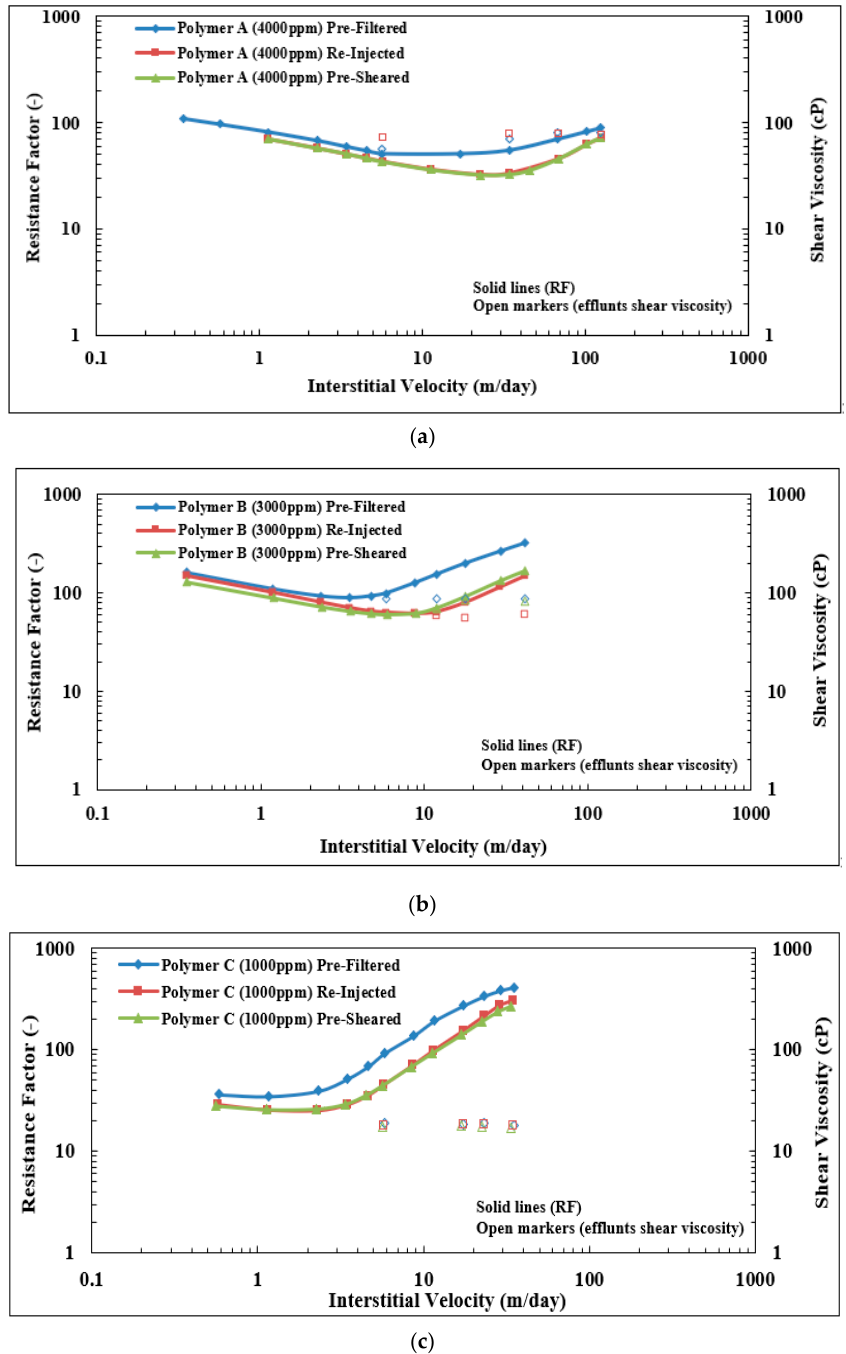
Figure 7 Resistance factor versus interstitial velocity for concentrated polymers A B and C at concentration of 4000 3000 and 1000 ppm, respectively. Open markers indicate effluent shear viscosity for the given velocity measured at γ(cid:4662) = 10 𝑠 (cid:2879)(cid:2869) . ( a ) Polymer A (Mw ≈ 8 MDa, Concentration = 4000 ppm); ( b ) Polymer B (Mw ≈ 12 MDa, Concentration = 3000 ppm); ( c ) Polymer C (Mw ≈ 18 MDa, Concentration = 1000 ppm).